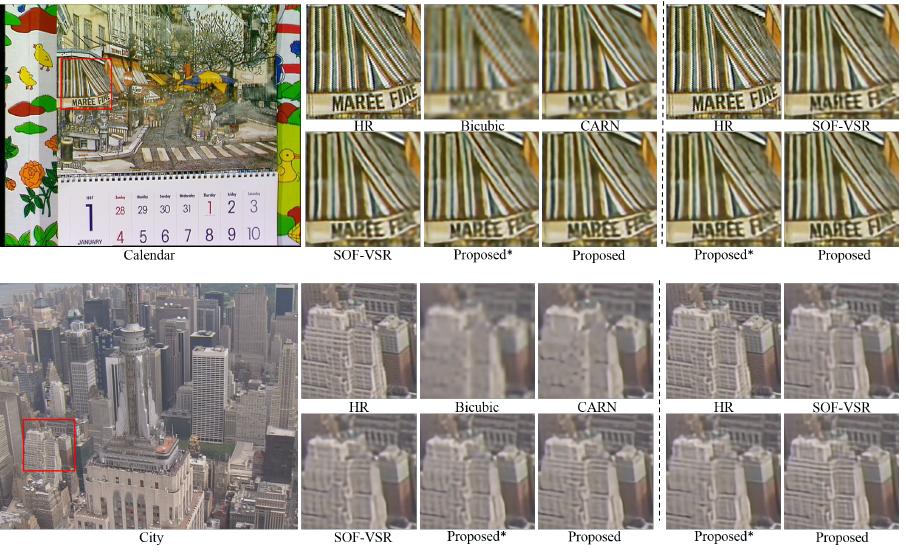
Figure 7. Visual comparisons of reconstruction results of × 4 scale on calendar and city video frames. The left side of the dashed line is the reconstruction result of the BI degradation model. The magnified area is the HR in sequence, and the reconstruction results of methods Bicubic, CARN, SOF-VSR, Proposed*, Proposed. The right side of the dashed line is the reconstruction result of the BD degradation model, and the zoomed-in area is HR, the reconstruction results of methods SOF-VSR, Proposed* and Proposed based on BD degradation model. The method marked with * only used non-local